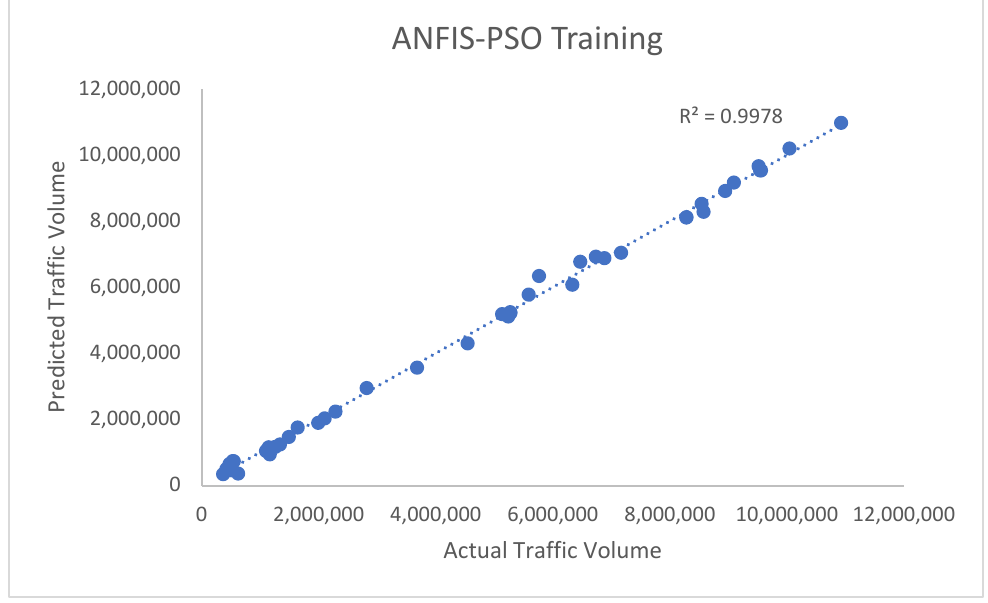
Figure 7. Comparison between the Actual South Africa Traffic volume versus the ANFIS-PSO Predicted traffic volume (Training).